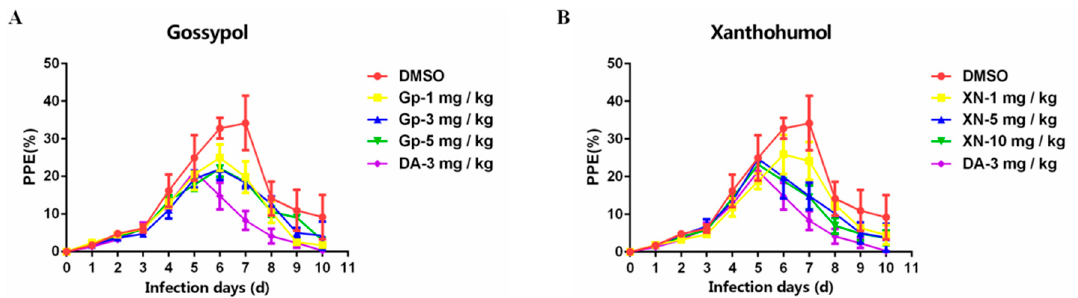
ff ect of Gp ( A ) and Xn ( B ) on the in vivo culture of B. microti Figure 8. The inhibitory effect of Gp ( A ) and Xn ( B ) on the in vivo culture of B. microti . Figure 8. The inhibitory e